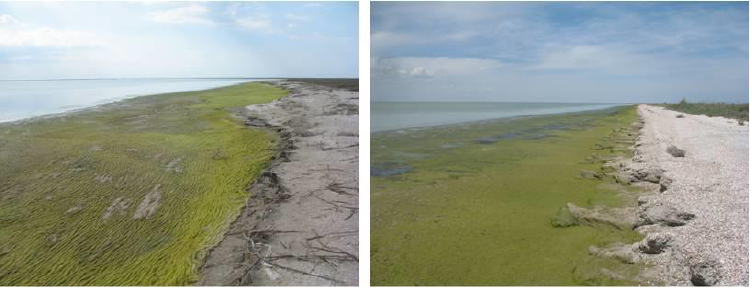
Figure 1. The mats of filamentous green alga Cladophora siwaschensis K.I. Meyer, 1922 in the hypersaline lagoon Sivash (Crimea).